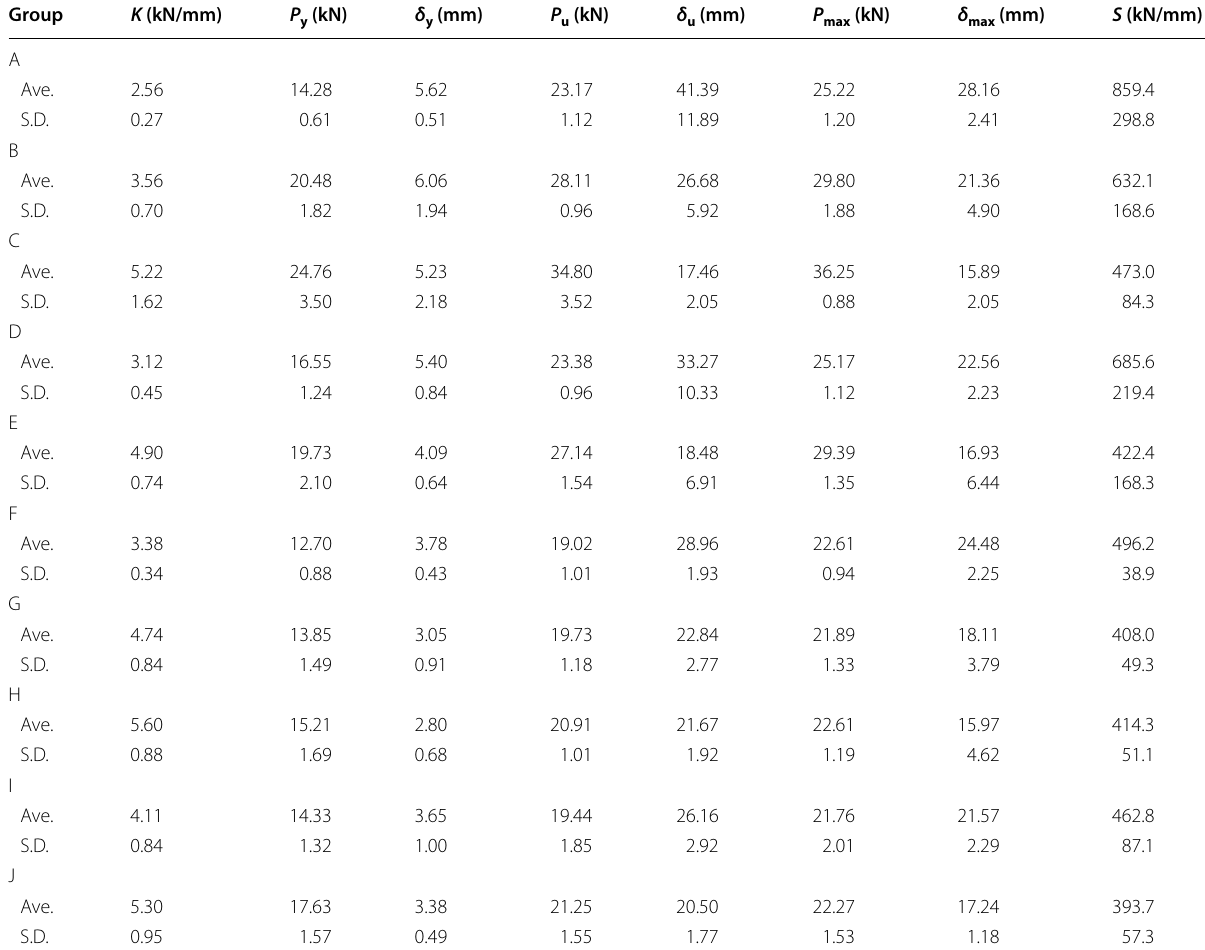
Table 3 Characteristics values obtained with a perfect elasto-plastic model